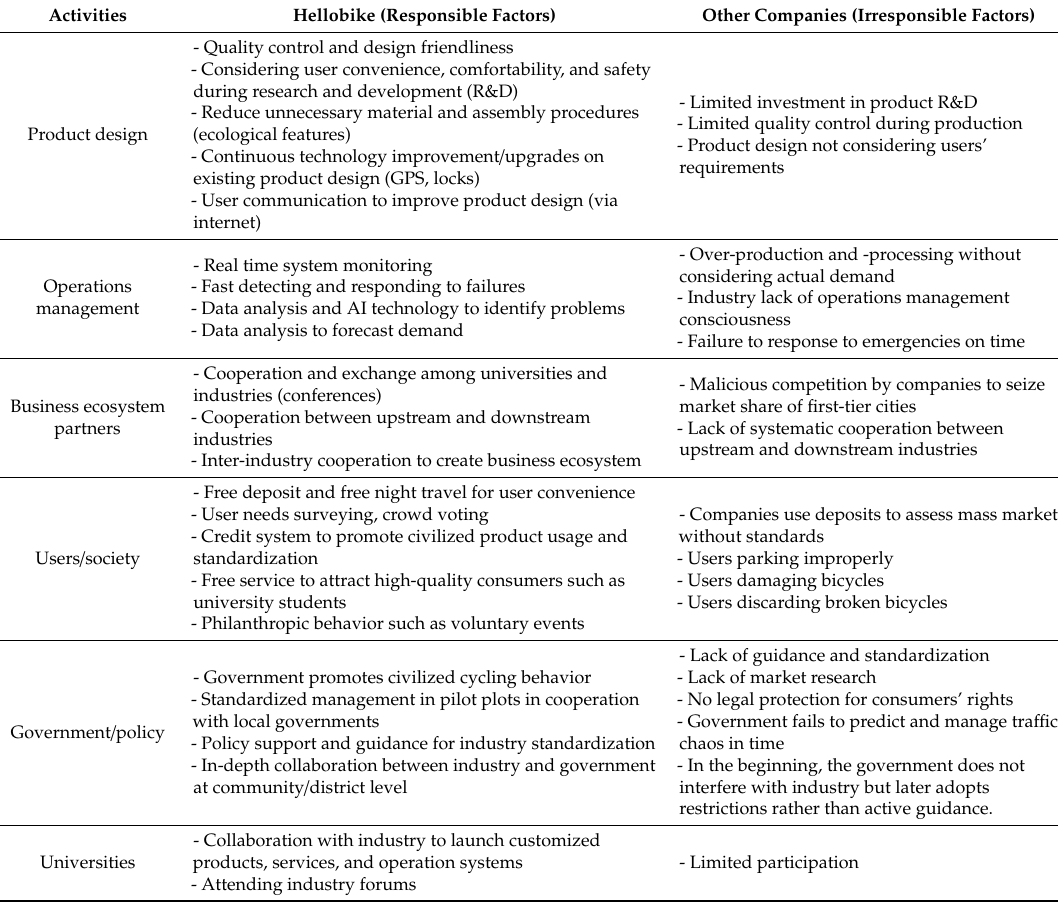
Table 1. A comparison of Hellobike and other shared bicycle organizations in China.